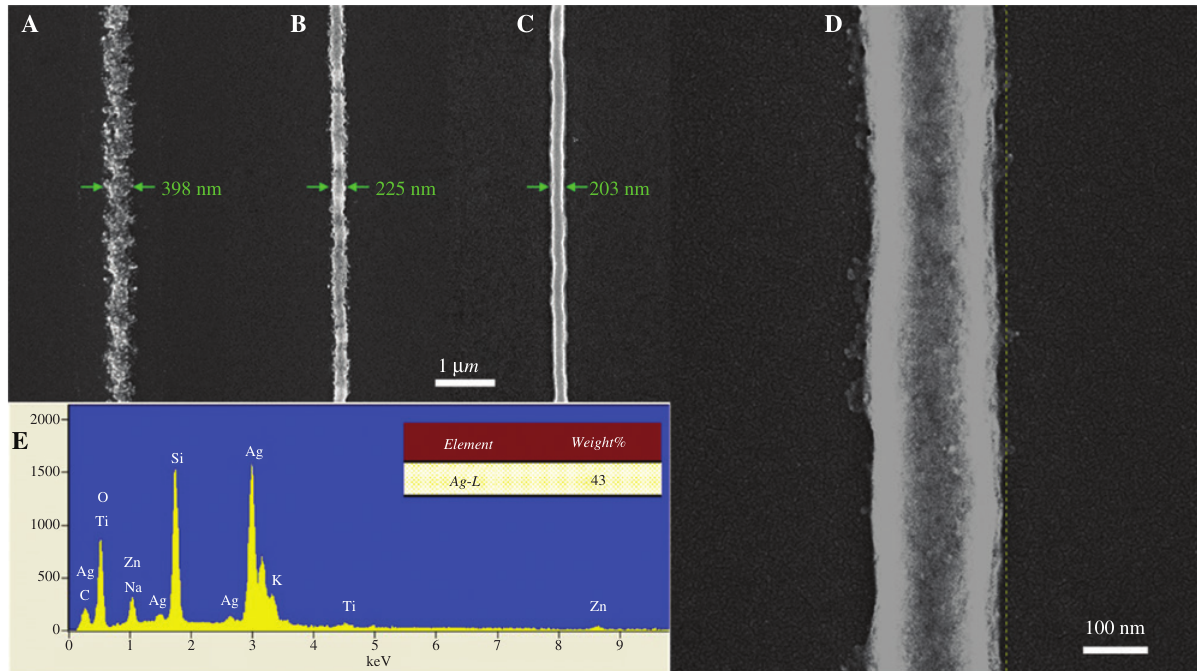
Figure 2: The SEM images of silver nanowires fabricated using the photoreduction solution containing the reductant or growth inhibitator. (A) Reductant only, (B) Growth inhibitor only, (C) Both the reductant and growth inhibitator. (D) The silver nanowires using photoreduction solution composed of AgNO , trisodium citrate and NDSS. (E) The energy-dispersive X-ray spectroscopy of the reduced silver structures on 3